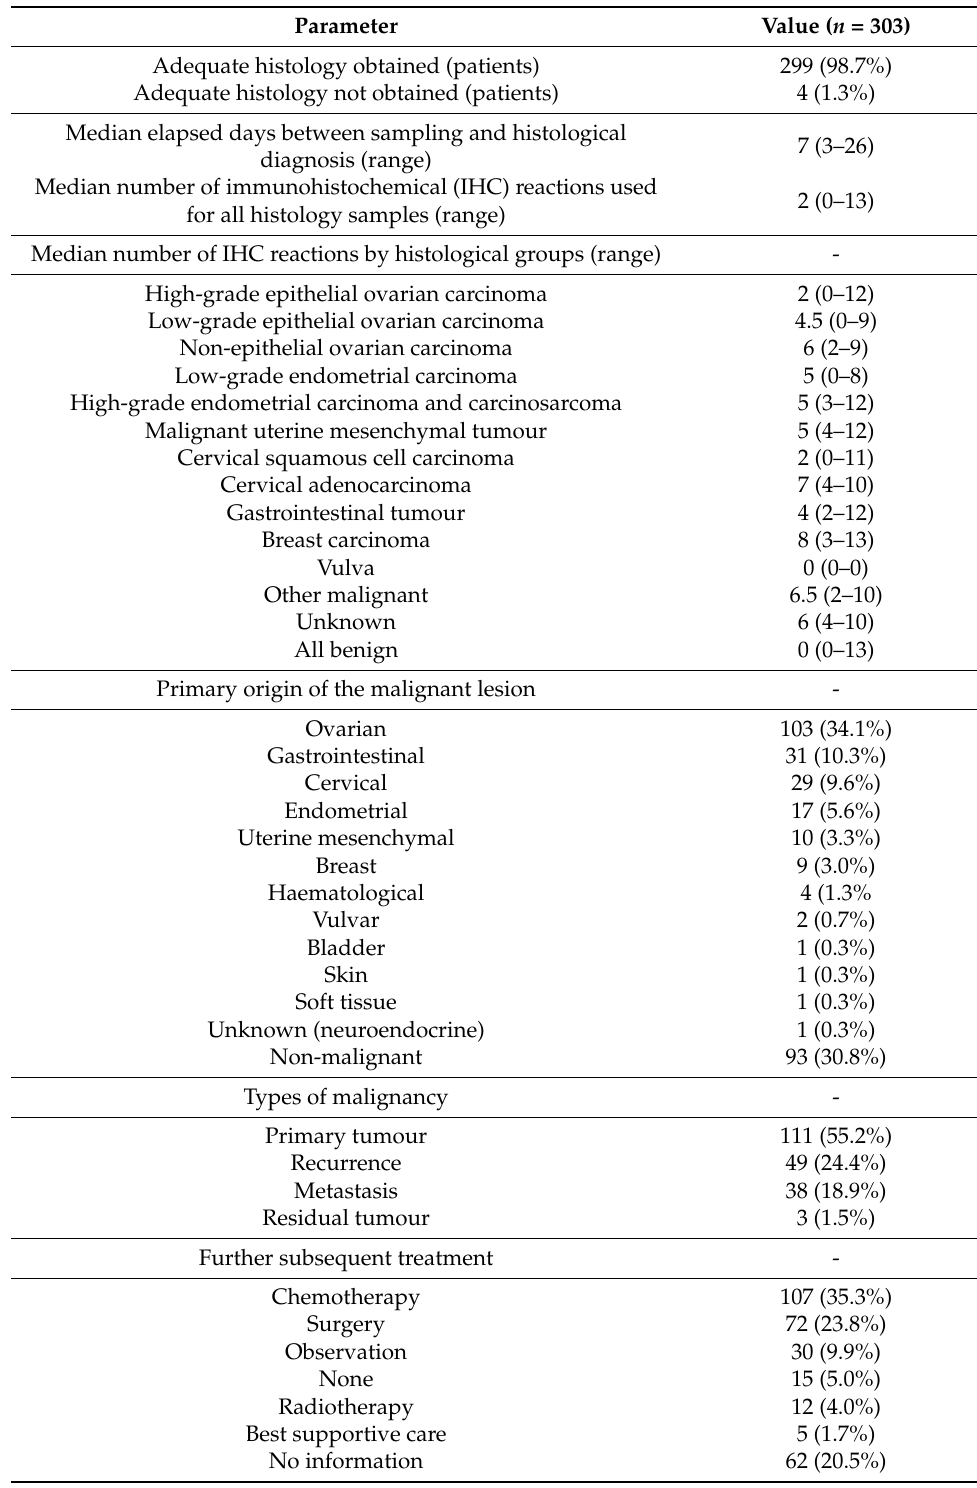
Table 2. Summarized results of the